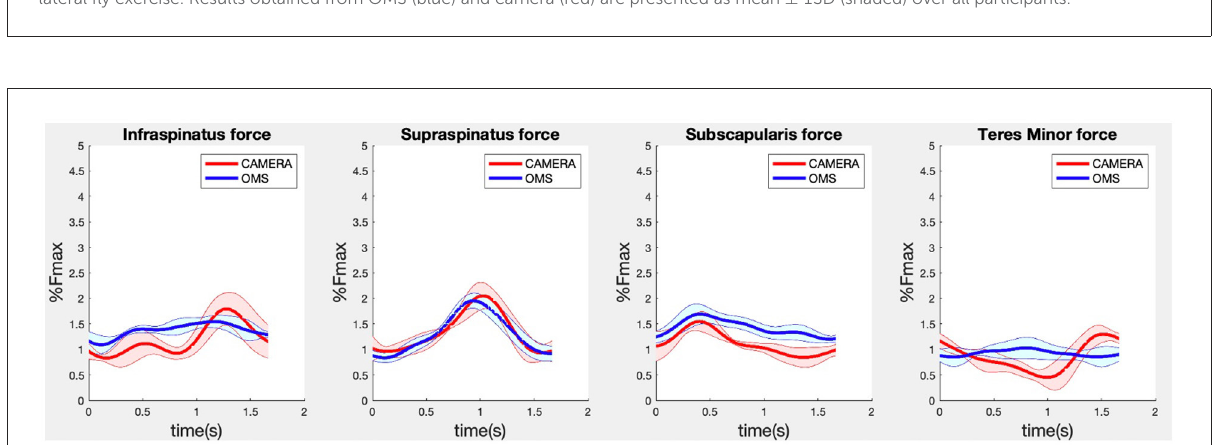
FIGURE5 Results for the trapezius scapula superior (left), trapezius scapula middle (middle), and trapezius scapula inferior (right) muscle forces during the lateral fly exercise. Results obtained from OMS (blue) and camera (red) are presented as mean ± 1SD (shaded) over all participants.